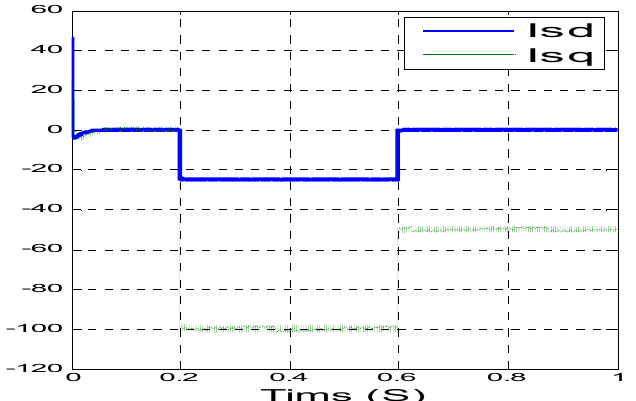
Figure 18. Direct currents and stator quadrature.